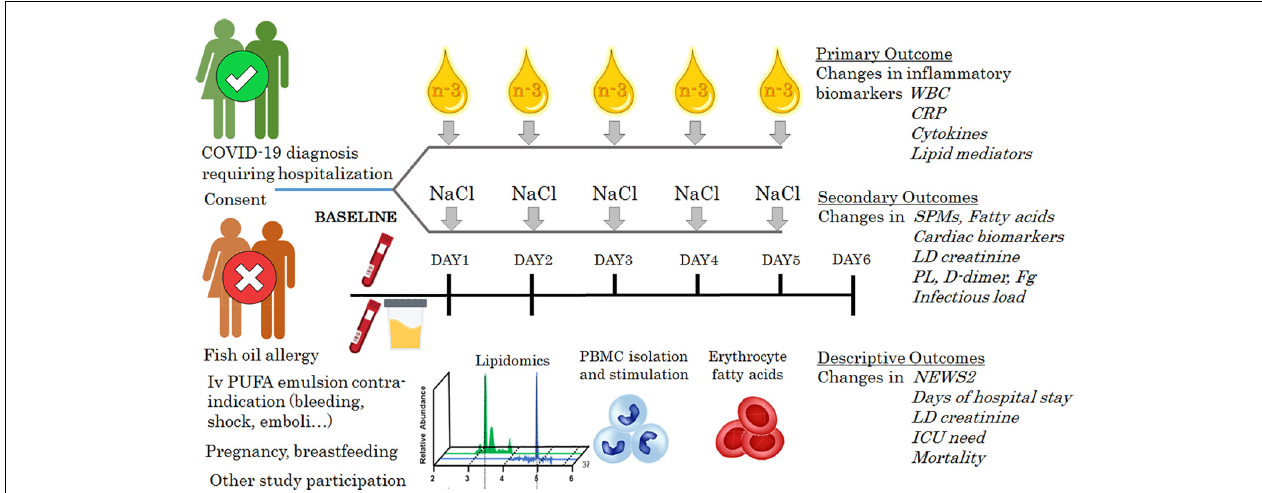
FIGURE 2 | Schematic study protocol for the COVID-Omega-F trial, registered in the European Union Drug Regulating Authorities Clinical Trials (EudraCT) database with number 2020-002293-28 and at ClinicalTrials.gov (clinicaltrials.gov/ct2/show/NCT04647604). An intravenous omega-3 PUFA emulsion (n-3) is compared with placebo (NaCl) for effects on a panel of inflammatory biomarkers; white blood cells (WBC), C-reactive protein (CRP), cytokines and lipid mediators at the end of the treatment period. Secondary endpoints include changes in specialized proresolving mediators (SPMs), fatty acids, cardiac markers, lactate dehydrogenase (LD), D-dimer, fribronogen (Fg), and infectious load. National Early Warning Score 2 (NEWS2), length of hospital stay, intensive cae unit (ICU) need, and mortality will be monitored for a descriptive analysis. The inclusion criteria for COVID-Omega-F comprise female and male patients ≥ 18 years of age diagnosed with COVID-19 and presenting with a clinical status requiring hospitalization. Exclusion criteria are defined according to i.v. omega-3 PUFA emulsion contraindications, known hypersensitivity, participation in other clinical research study, pregnancy, and breastfeeding.